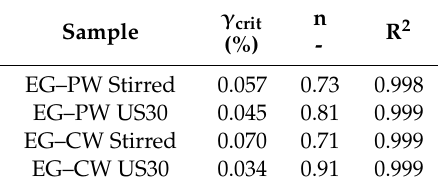
Figure 9. Rheological behavior of EG–wax systems at 80 ◦ C: ( a ) dynamic strain sweep at 6.28 rad / s; ( b ) frequency sweep measurements at 0.03% strain. Table 4. Rheological parameters for the PW- and CW-based